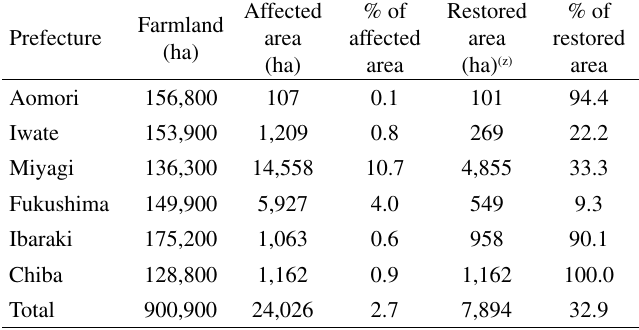
Table created from databases of MAFF 2011 and